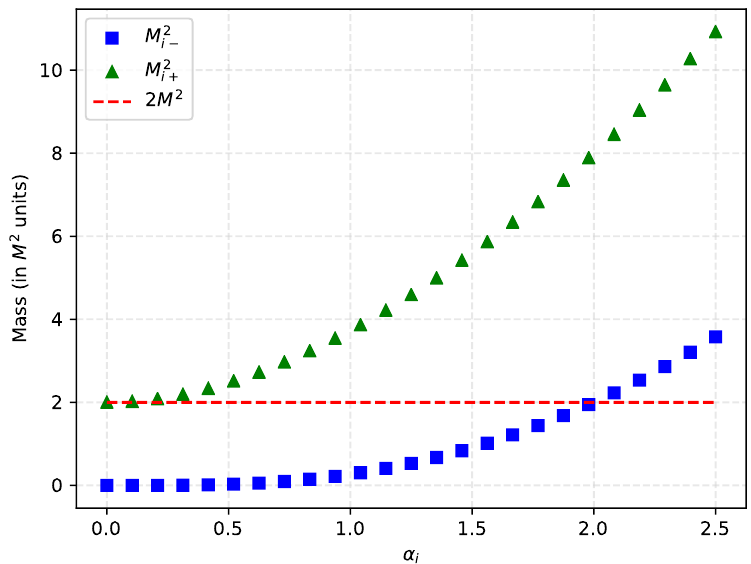
p = 1 + (cid:11) 2 (cid:6) 1 + 2 (cid:11) 2 with (cid:11) i i (cid:6) i i goes to zero for small i (cid:0)